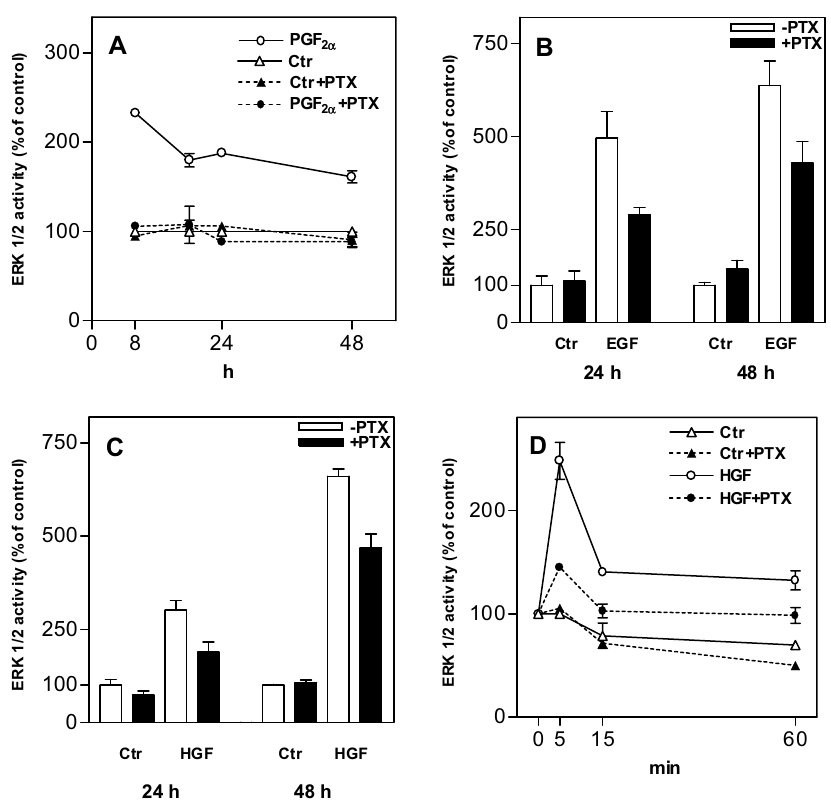
Figure 1 Effect of pertussis toxin (PTX) on ERK1/2 activation. PTX was added to cultured hepatocytes at 3 h after the time of seeding. A: ERK1/2 activation in the absence or presence of PTX (400 ng/ml) in response to stimulation with PGF 2 α (10 µ M) for 5 min in the period from 8 h to 48 h. B, C: Effect of PTX (300 ng/ml) on ERK1/2 activation in response to stimulation with EGF (10 nM) (B) or HGF (100 ng/ml) (C) for 5 min at 24 and 48 h. D: Time-course for HGF- (100 ng/ml) induced ERK1/2 acti- vation in the absence or presence of PTX (300 ng/ml). Results in A-D represent means ± S.E.M. from three